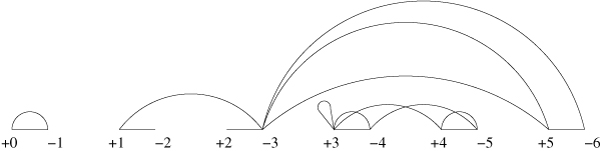
The breakpoint graph. The breakpoint graph of π=(0→1→3→3←5←4→3←5←4←3←6→). The edge (-3, +5) has a multiplicity of 2, all other edges have a multiplicity of 1. The edge (+3, +3) is a loop. The breakpoint graph consists of three components, the edge (+1, -3) is a 1-bridge, and the pair of edges (+3, +4), (-4, -5) is a 2-bridge.